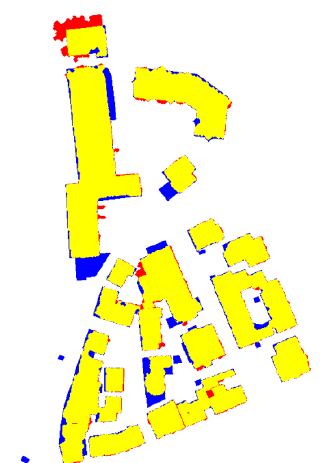
Figure 4. Buildings classification (correctly classified as yellow, misclassified as red, missing as blue) .